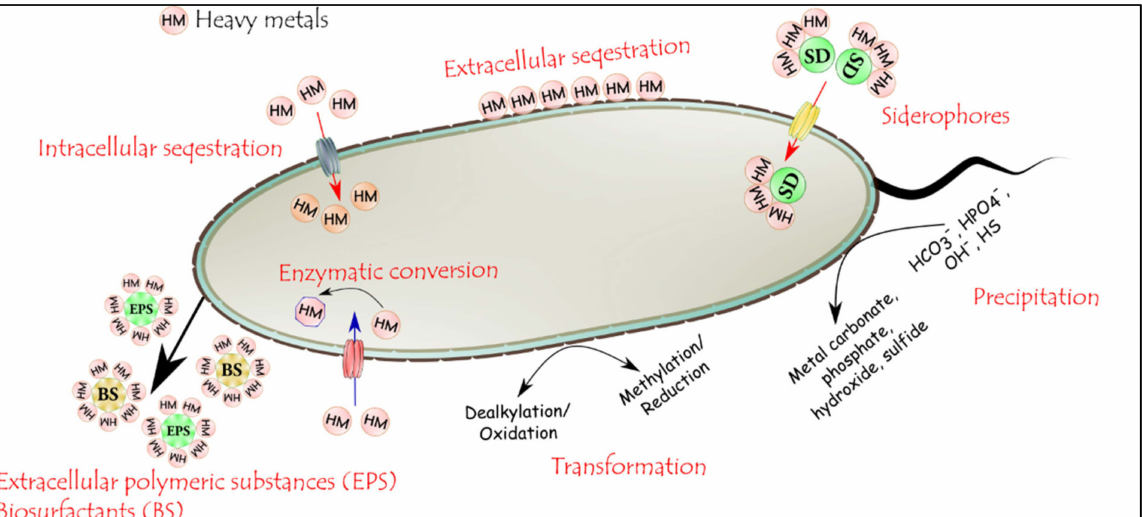
Figure 4. Schematic representation of various mechanisms involved in microbial remediation of HM- contaminated soil. HMs: Heavy metals; SD: Siderophores; EPS: Extracellular polymeric substances; BS: